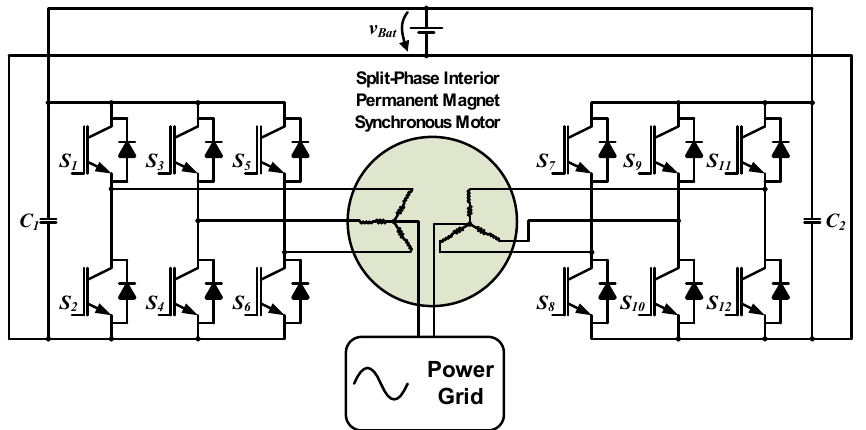
Figure 5. Non-isolated, single-phase unified power converter topology based on a split-phase interior PMSM [14].